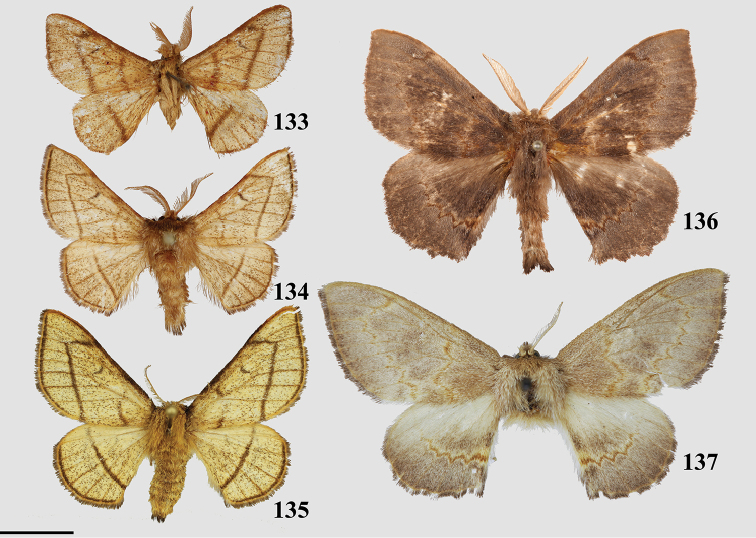
Adult specimens of type species (except where noted) of genera belonging to Druenticinae: Luramini, note that two species of Lurama are figured to better illustrate this genus. 133Luramapenia, male [reused with permission from St Laurent (2016), ZooKeys] (USNM) 134L.quindiuna, male, not type species of Lurama [reused with permission from St Laurent (2016), ZooKeys] (MWM) 135L.quindiuna, female, not type species of Lurama [reused with permission from St Laurent (2016), ZooKeys] (MWM) 136Ulmararotunda, male [photo T Malm] (NHRS) 137U.rotunda, [reused with permission from St Laurent (2016), ZooKeys] (MNHU). Scale bar: 1 cm.